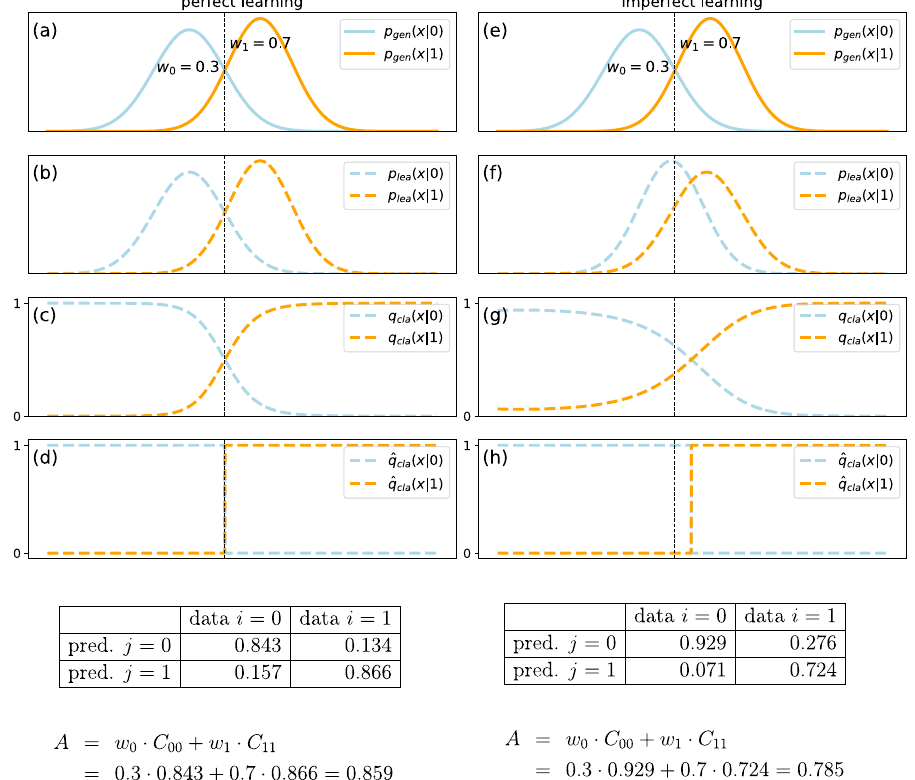
Figure 2. Illustration of the accuracy limit in classification tasks. A data source is generating data points from two possible classes i = 0 and i = 1 , which occur with probabilities w 0 = 0.3 and w 1 = 0.7 and are distributed according to p gen ( x | 0 ) and p gen ( x | 1 ) , respectively (Panels a , e ). A classifier trained on these data can end up learning the class distributions perfectly, so that p lea ( x | i ) = p gen ( x | i ) (Panel b ). It can also end up with an imperfect approximation of the distributions, so that p lea ( x | i ) ≈ p gen ( x | i ) (Panel f ). The learned distributions p lea ( x | i ) determine the probabilities q cla ( j | x ) ∈ [0, 1] that a given input data point x will be assigned to class j (Panels c,g. See Methods for details). In a classifier with ’one-hot’-output, the continuous classification probabilities are binarized to ˆ q cla ( j | x ) ∈ { 0, 1 } , so that the input space is partitioned into disjunct, class-specific regions (Panels d , h ). The classification probabilities ˆ q cla ( j | x ) together with the true data distributions p gen ( x | i ) determine the (normalized) confusion matrix C ji = (cid:31) ˆ q cla ( j | x ) p gen ( x | i ) dx of the classifier, from which the accuracy can be computed as A = (cid:31) K i = 1 w i C ii (See matrices and numerical examples below the figure panels). For the case shown in the figure, the accuracy of the imperfect classifier A = 0.785 is smaller than that of the perfect classifier with A = 0.859 , but even the latter is smaller than one. It represents the accuracy limit of this classification problem, which is determined by the natural overlap of data